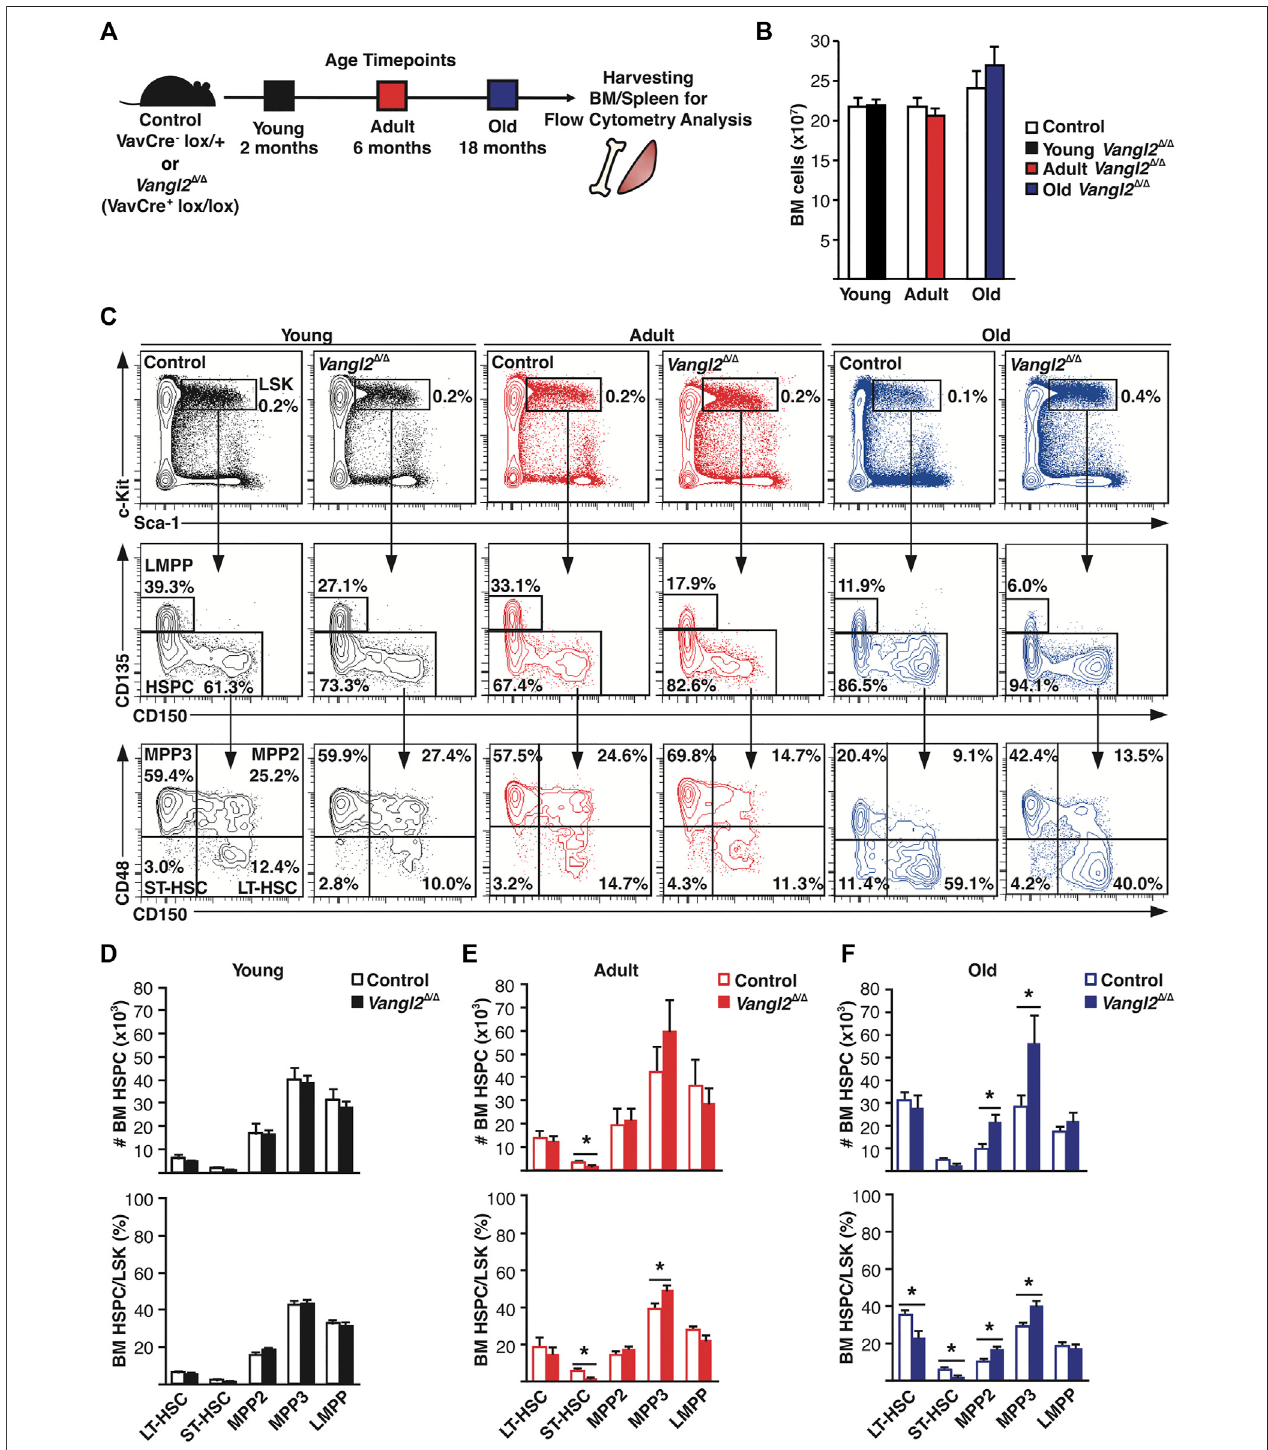
FIGURE1| Vangl2lossinhematopoieticcellsincreasesmyeloid-biasedmultipotentprogenitorcellnumbersinoldmice. (A) Experimentaldesignfor fl owcytometry analysis of young (2-month-old, in black), adult (6-month-old, in red) and old (18-month-old, in blue) VavCre + Vangl2 lox/lox mice in which Vangl2 is ablated in all hematopoietic lineages ( Vangl2 Δ / Δ ) and littermate controls. (B) Histogram represents absolute numbers of BM cells per leg (tibia + femur) for young, adult and old mice (mean +SEM). (C) Representative fl ow cytometry data are shown for young, adult and old mice. Populations were de fi ned as follows: Lin − Sca1 + c-Kit + (LSK), CD135 + CD48 + CD150 − (LMPP), CD135 − CD48 + CD150 − (MPP3), CD135 − CD48 + CD150 + (MPP2), CD135 − CD48 − CD150 − (ST-HSC) and CD135 − CD48 − CD150 +